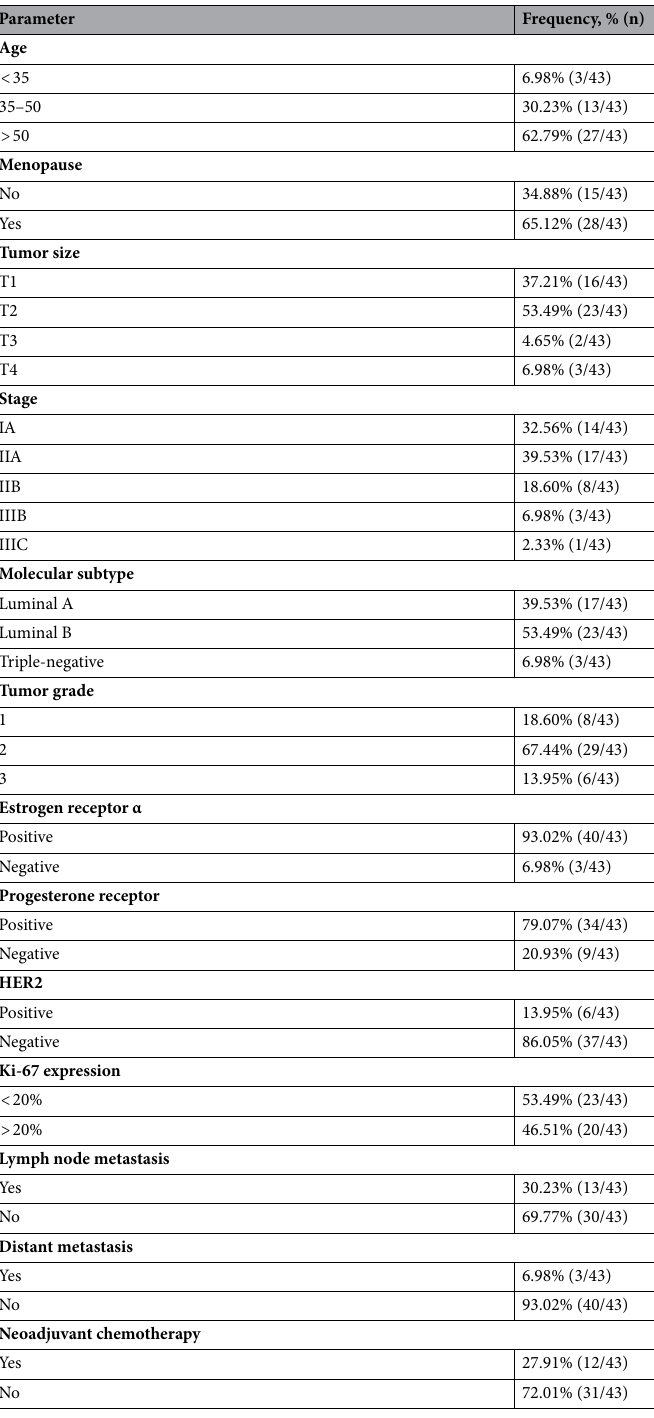
Table 1. Clinicopathological characteristics of